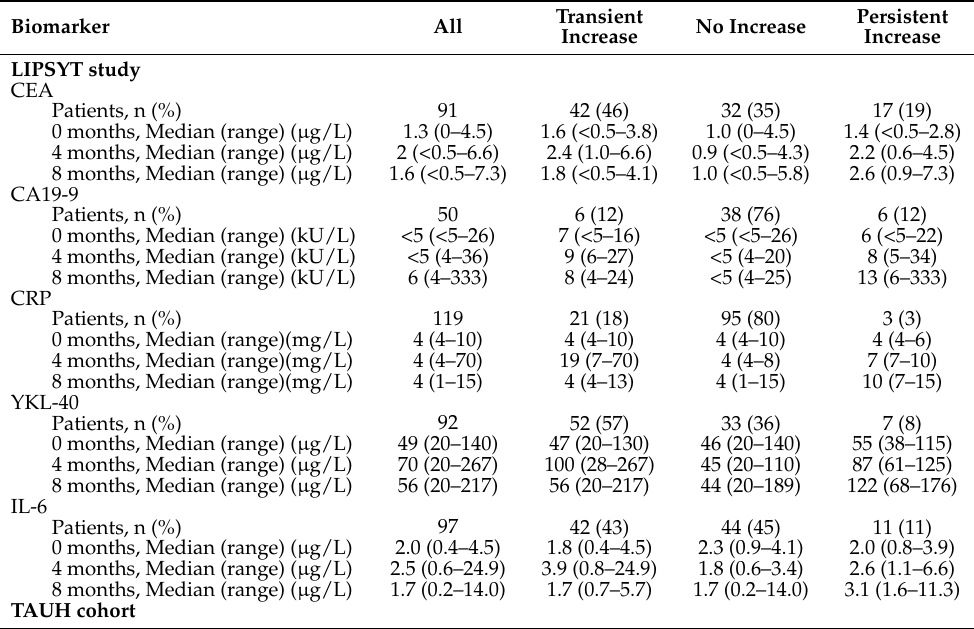
Table 2. Biomarker dynamics during adjuvant chemotherapy in the three cohorts with name marked in bold. Cut-off values: CEA > 5 µ g/L, CA19-9 > 26 kU/L, YKL-40 > 90th percentile at baseline, CRP > 10 mg/L, and IL-6 > 4.5